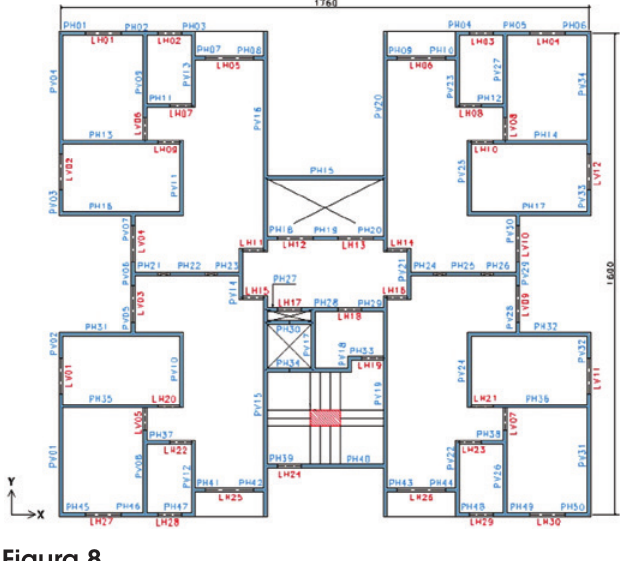
Planta baixa do edifício (Fonte: Braguim, 2013)